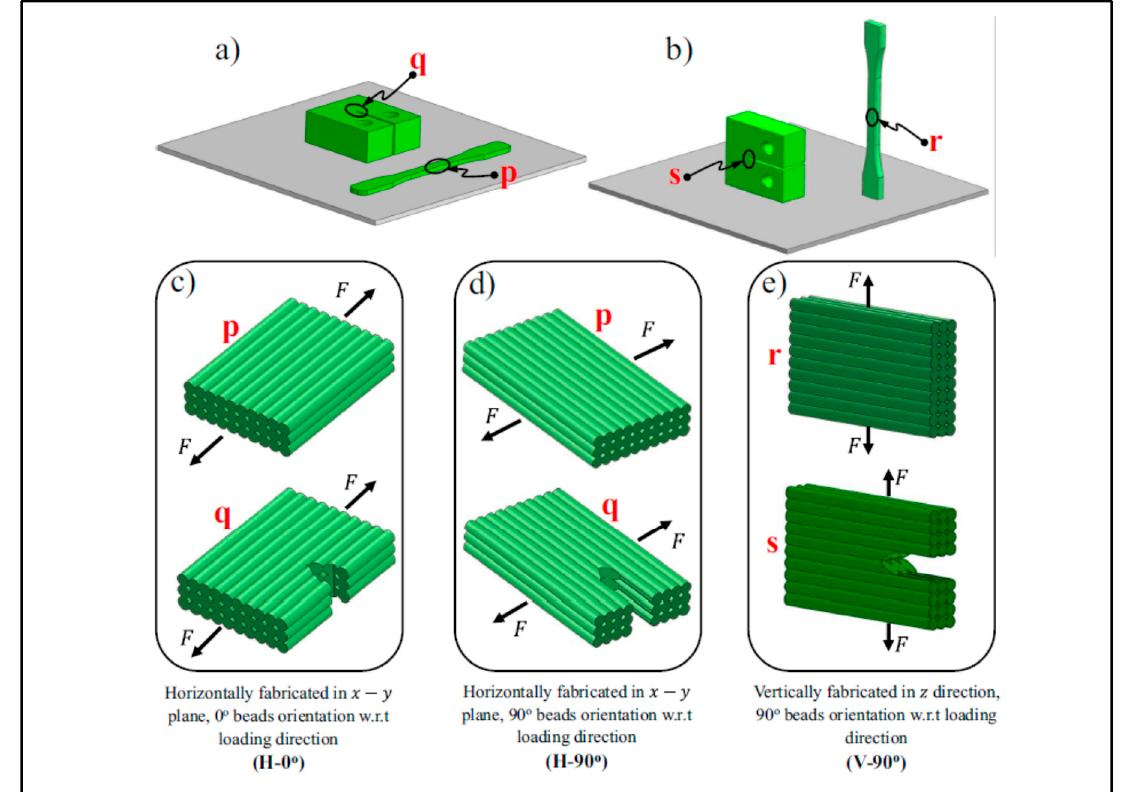
Figure 4. Configurations of samples fabricated ( a ) horizontally or ( b ) vertically. The deposition pattern is ( c ) 0° beads orientation or ( d , e ) 90° beads orientation [93].